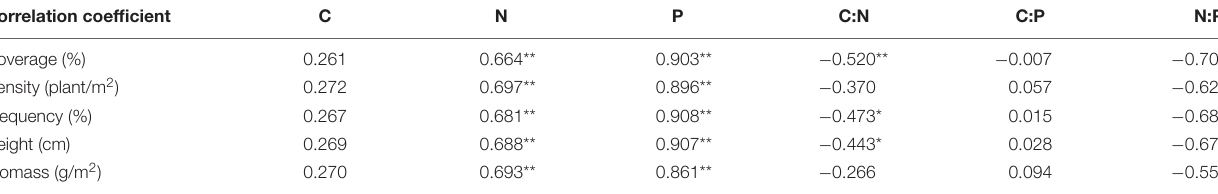
TABLE 2 | Correlation between stoichiometry and population characteristics of P. australis . Correlation